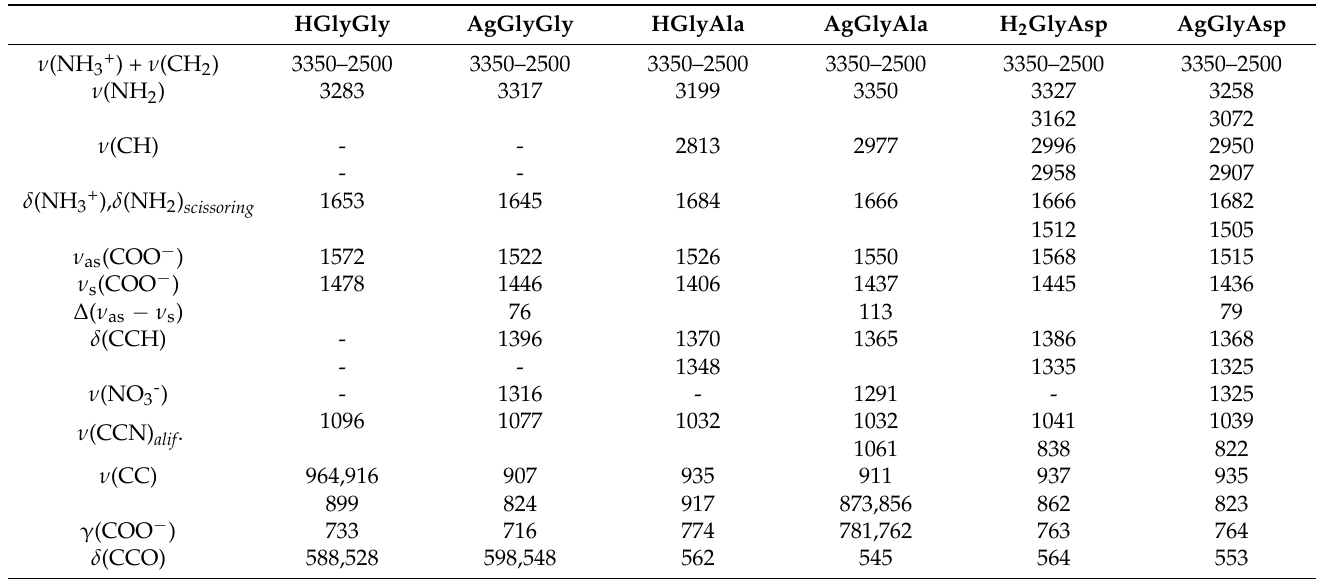
Table 1. IR spectral data assignments for complexes AgGlyGly, AgGlyAla and AgGlyAsp and their appropriate ligands HGlyGly, HGlyAla and H 2 GlyAsp.